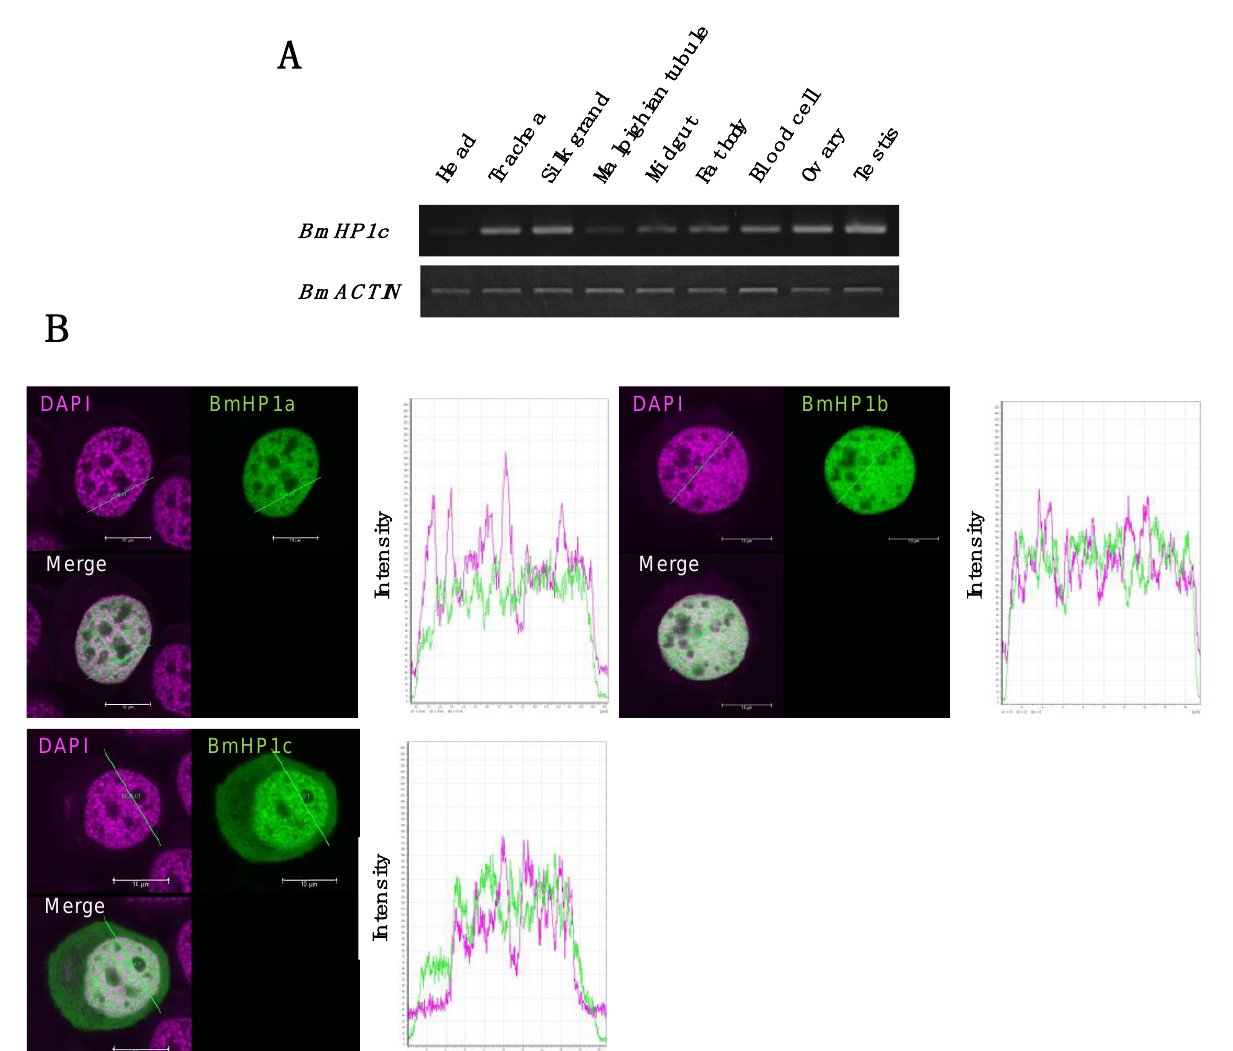
Figure 4. ( A ) BmHP1c expression analysis for each tissue. Total RNA was extracted from each silkworm tissue, cDNA was synthesized, and then PCR was performed with BmHP1c specific primers. BmACTIN was used to normalize the variability in template loading. ( B ) Localization of BmHP1s in BmN4 cultured cells. A vector expressing mClover3 fused BmHP1s was transfected into BmN4 and observed with a confocal microscope. Left panel: photomicrograph. Right panel: The fluorescence intensity at the position indicated by the green line in the right panel.